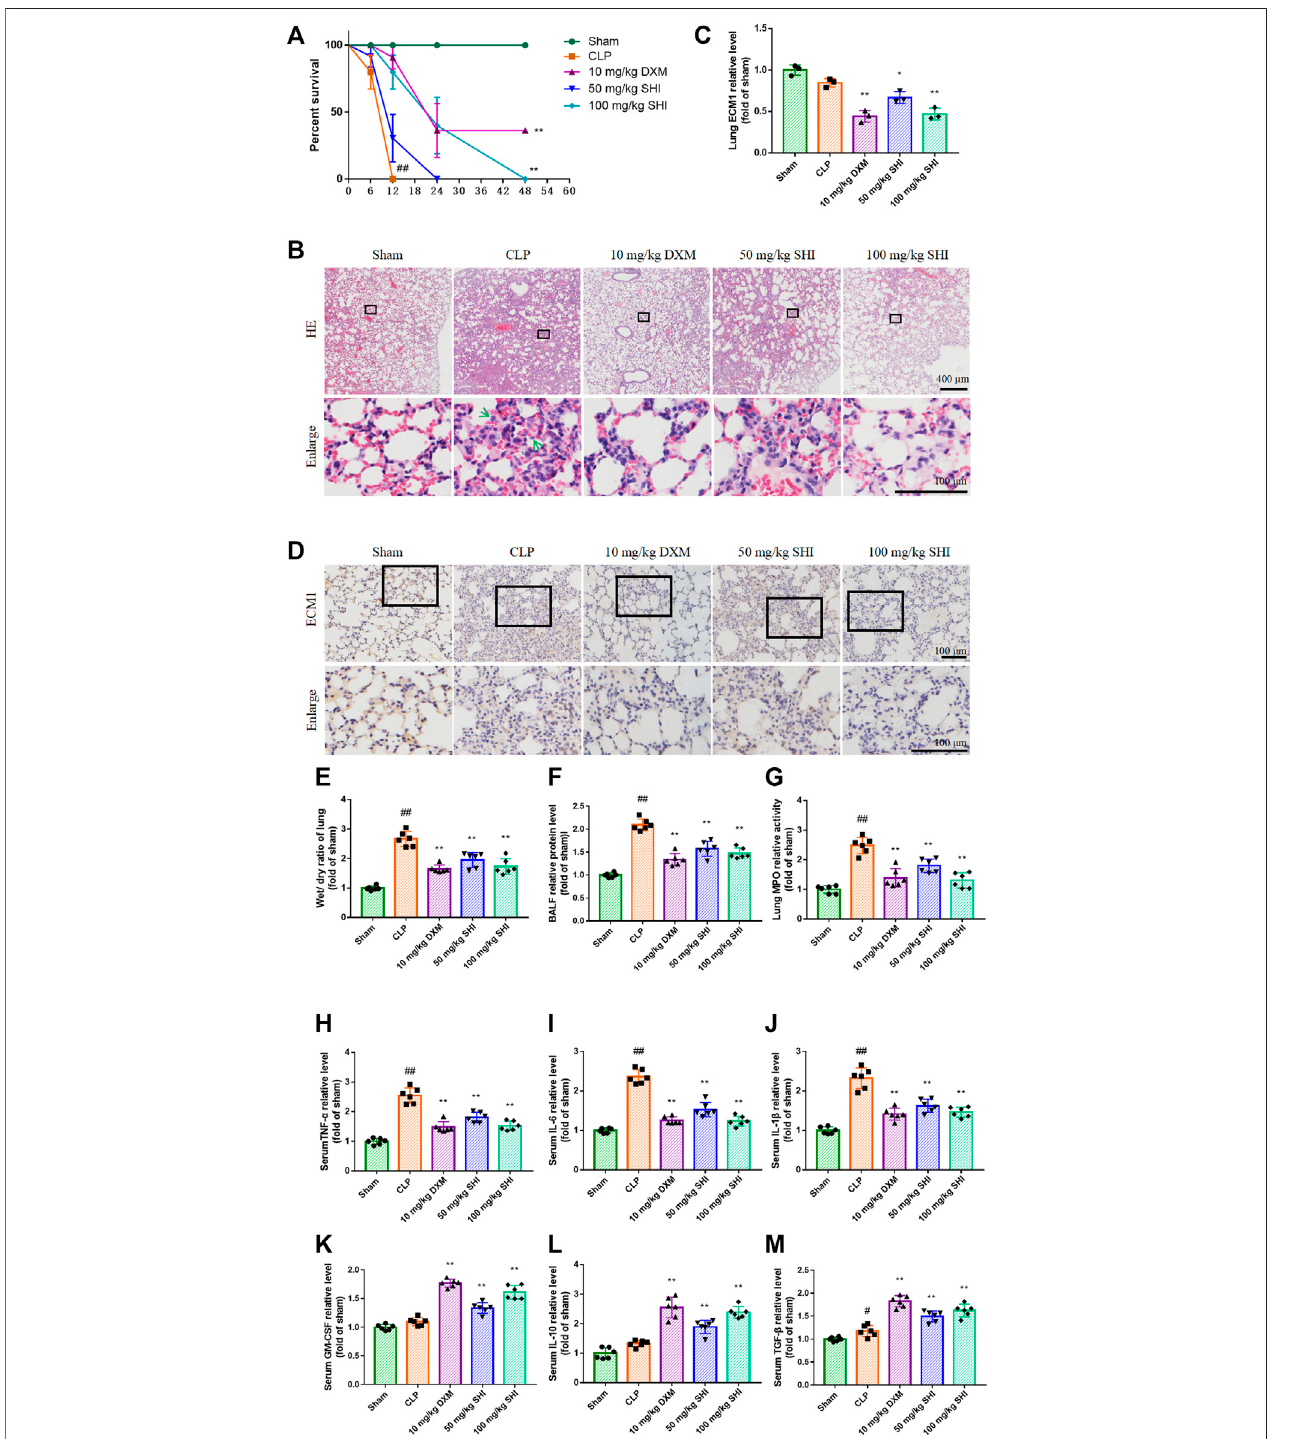
FIGURE 1 | The effect of SHI on sepsis-induced ALI. The mice were intragastrically treated with drugs 2 h before the surgery, and at 0, 2, 12 h after the CLP surgery. (A) The survival percentage of sepsis mice. (B) The histopathological alteration by H&E staining. The green arrows indicate the in fi ltration of in fl ammatory cells. (C,D) ECM1 expression in the lung tissues by immunohistochemistry staining. (E) The wet/dry ratio of the lungs. (F) The BALF relative protein levels. (G) The lung MPO activity. The serum relative levels of (H) TNF- α , (I) IL-6, (J) IL-1 β , (K) GM-CSF, (L) IL-10, and (M) TGF- β . The data are expressed as mean ± SD. Compared with sham: # p < 0.05, ## p < 0.01. Compared with CLP: * p < 0.05, ** p < 0.01.